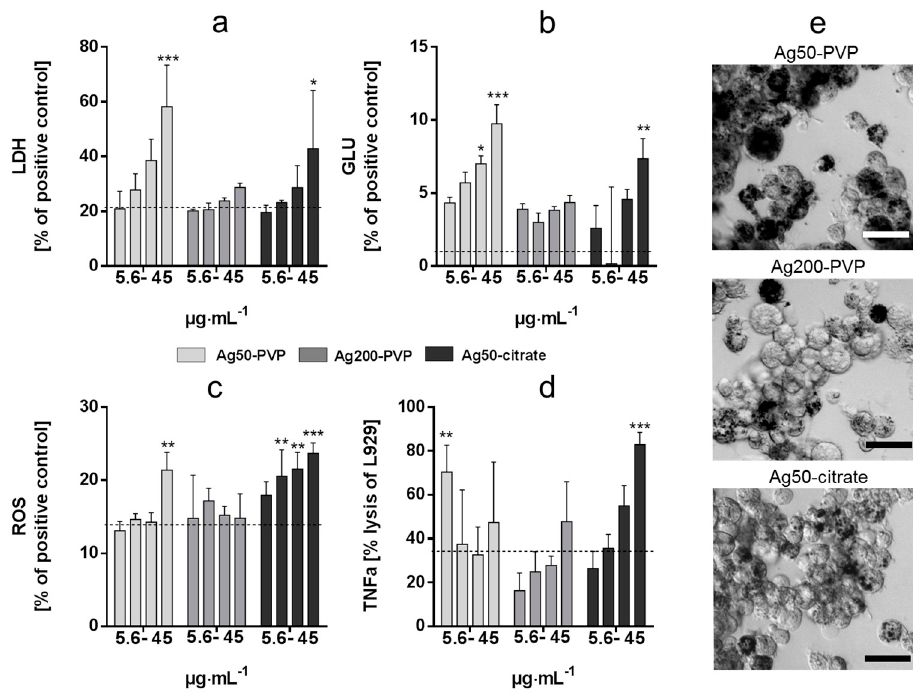
Figure 1. In vitro effects of Ag50-polyvinilpyrrolidone (PVP), Ag200-PVP and Ag50-citrate nanoparticles (NPs) on alveolar macrophages (NR8383). Four concentrations (5.6, 11.25, 22.5 and 45 µg·mL − 1 ) were applied for 16 h ( a , b , d ) or 90 min ( c ). Supernatants were tested for activity of lactate dehydrogenase (LDH) ( a ) and glucuronidase (GLU) ( b ) relative to the positive control (Triton X-100). Release of H 2 O 2 ( c ) is expressed relative to the positive control (zymosan). Bioactive tumor necrosis factor (TNF)- α was measured as percent lysis of L-929 reporter cells ( d ). Data are means±standard deviation (SD) from three independent experiments; dashed lines indicate mean values of untreated control cells; * p < 0.05, ** p < 0.01, *** p < 0.001. Uptake of silver NP (45 µg/mL, 16 h) is shown in ( e ). Note that while the bottom of the culture dish is clear, Ag-NPs appear as black grains localized intracellularly; bars: 20